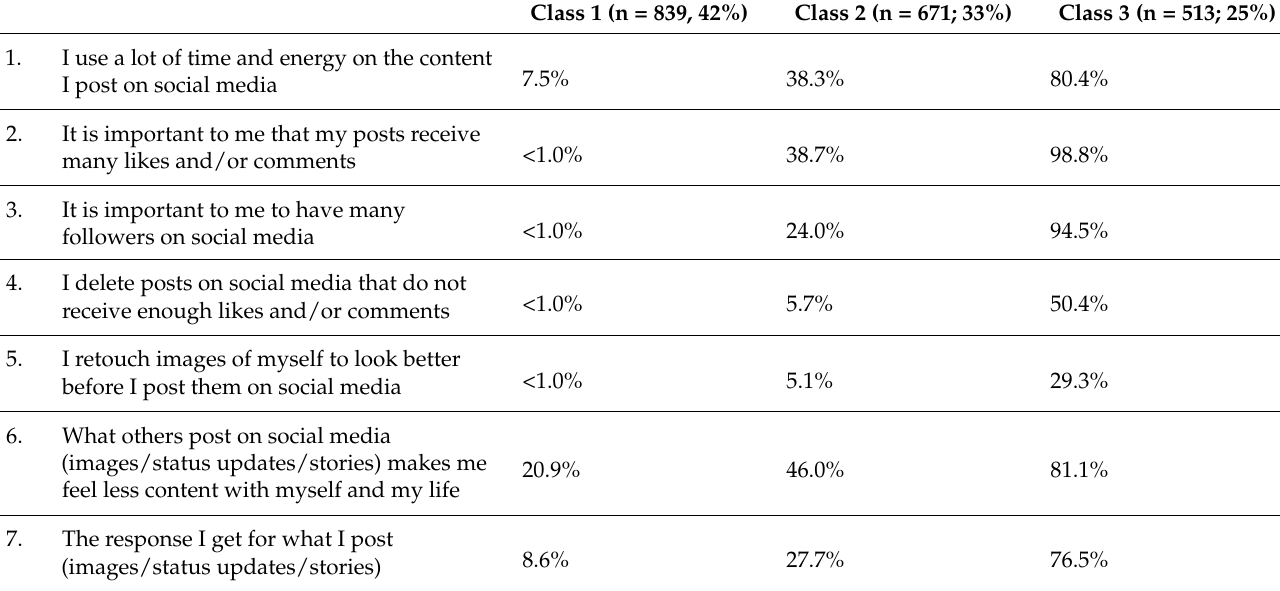
Figure 2. Response probabilities on the self-presentation scale across retained classes. Table 4. The probability of endorsing (i.e., responding “sometimes/partly true”, “a lot”, or “very much”) each of the SPAUSCIS items across retained